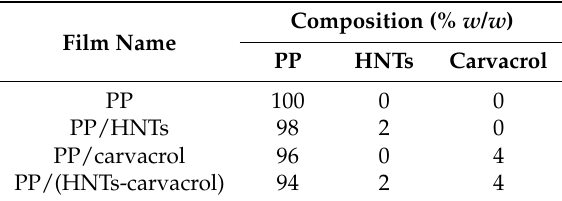
Table 1. Composition of studied